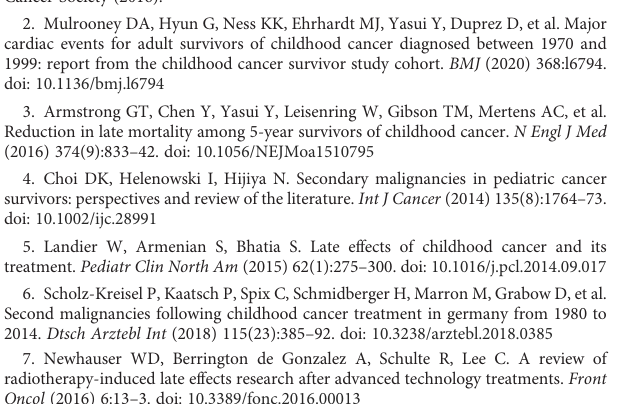
participants of the nested case-control study